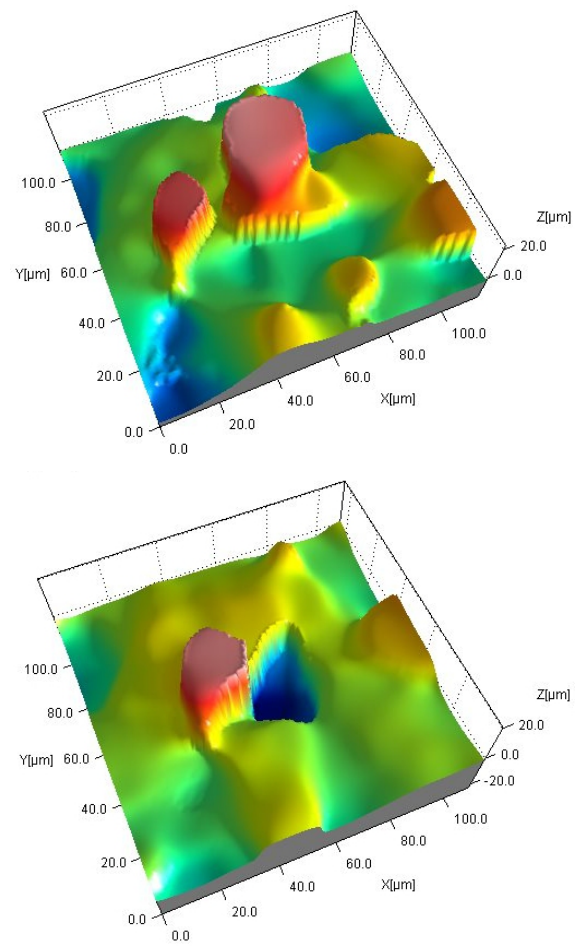
Figure 2. Abrasive grain on the grinding-wheel AS before grinding ( top ) and after grinding using that wheel ( bottom ): visible wear due to grain crushing (views obtained from replicas).